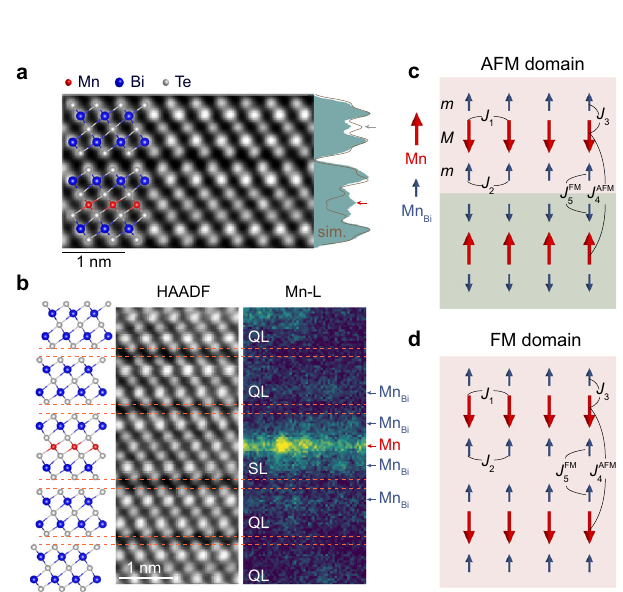
through its T N . e 2D plot of RMCD signal as functions of temperature and magnetic fi eld(descendingsweep)forthe3-SLMnBi 6 Te 10 fl ake.TwoAFMspin- fl ip fi elds ( H 1 H 2 fl ip fi eld ( H c – ) are extracted and f (cid:1) and f (cid:1) ) and one FM spin- superimposed on the plot. The error bars correspond to the range of the transition during each spin fl ip. f , g Proportions of FM ( f FM , left axis) and AFM ( f AFM , right axis) component as functions of thickness ( f ) and temperature ( g ). Cross marks in ( f ) indicate the expected values for the single-domain case. The vertical error bars are estimated from the experimental uncertainty of the measured signal.